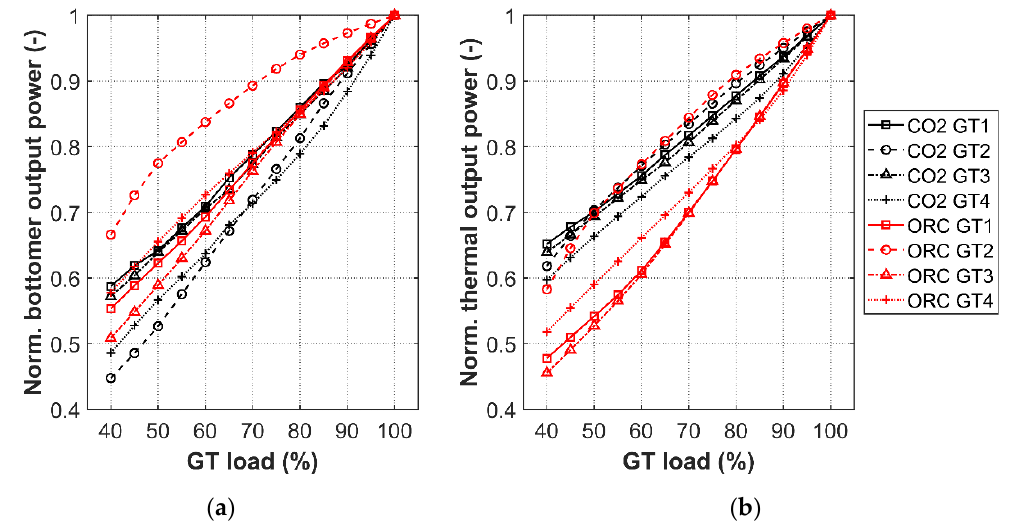
Figure 9. Bottoming cycles’ part-load performance: ( a ) electric power output and ( b ) thermal power output, normalized to their design values.